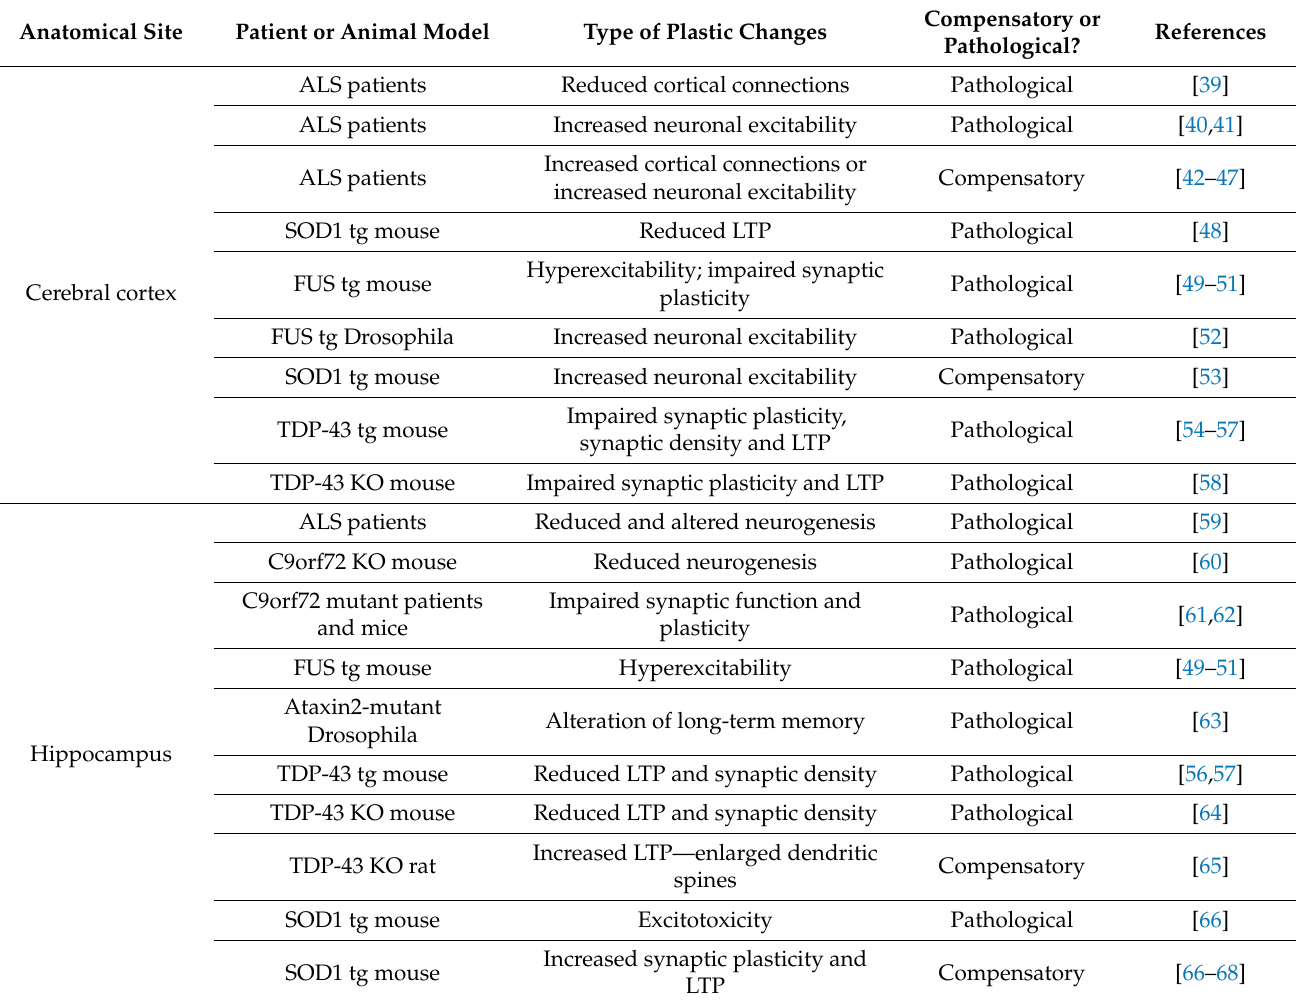
Table 1. Mechanisms of synaptic plasticity and their involvement in ALS